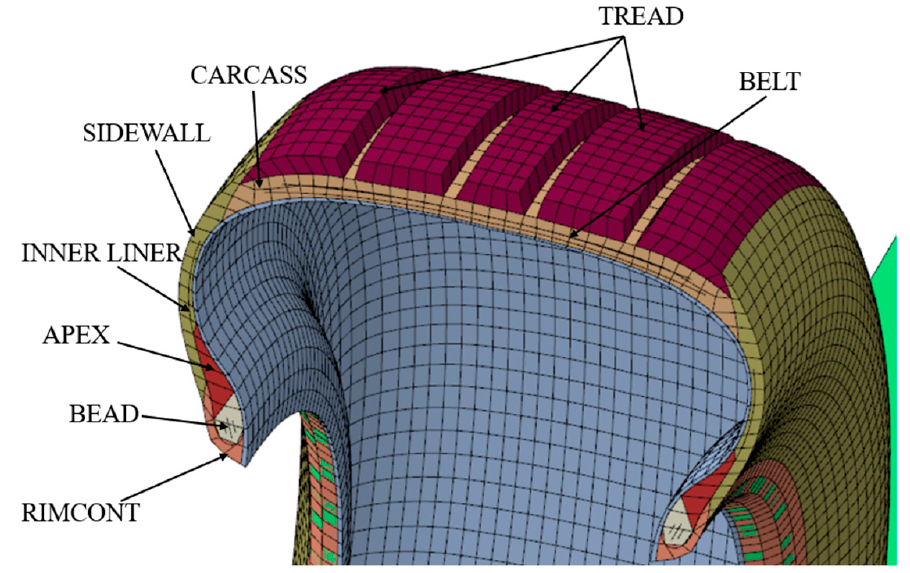
Figure 3. The finite element model of aircraft tire section.